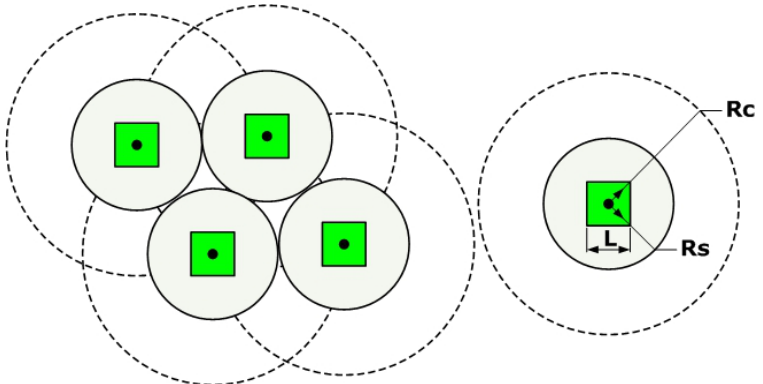
Figure 7. Sensing range and communicating range of the mobile